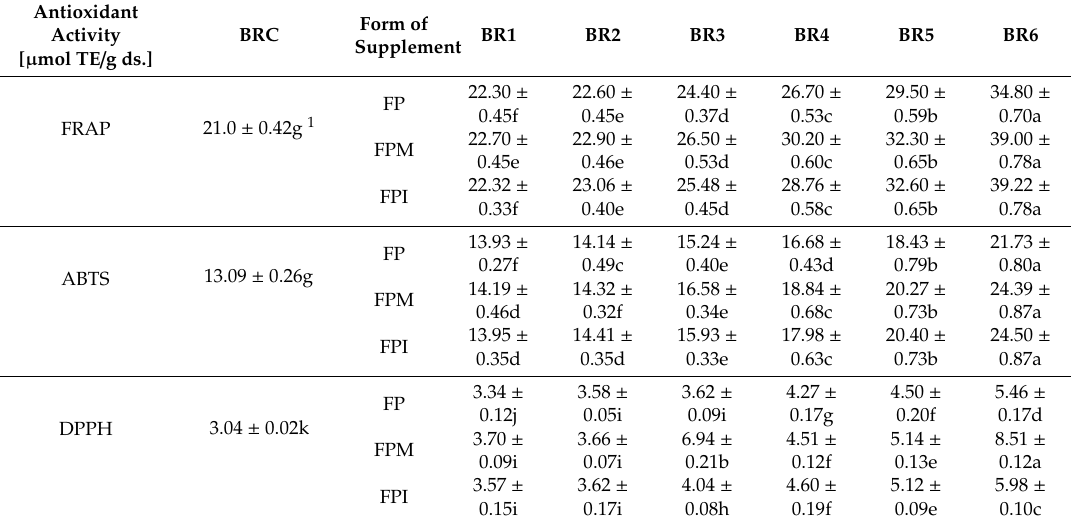
Table 4. The antioxidant activity of rye bread fortification with functional additives without and with carriers.